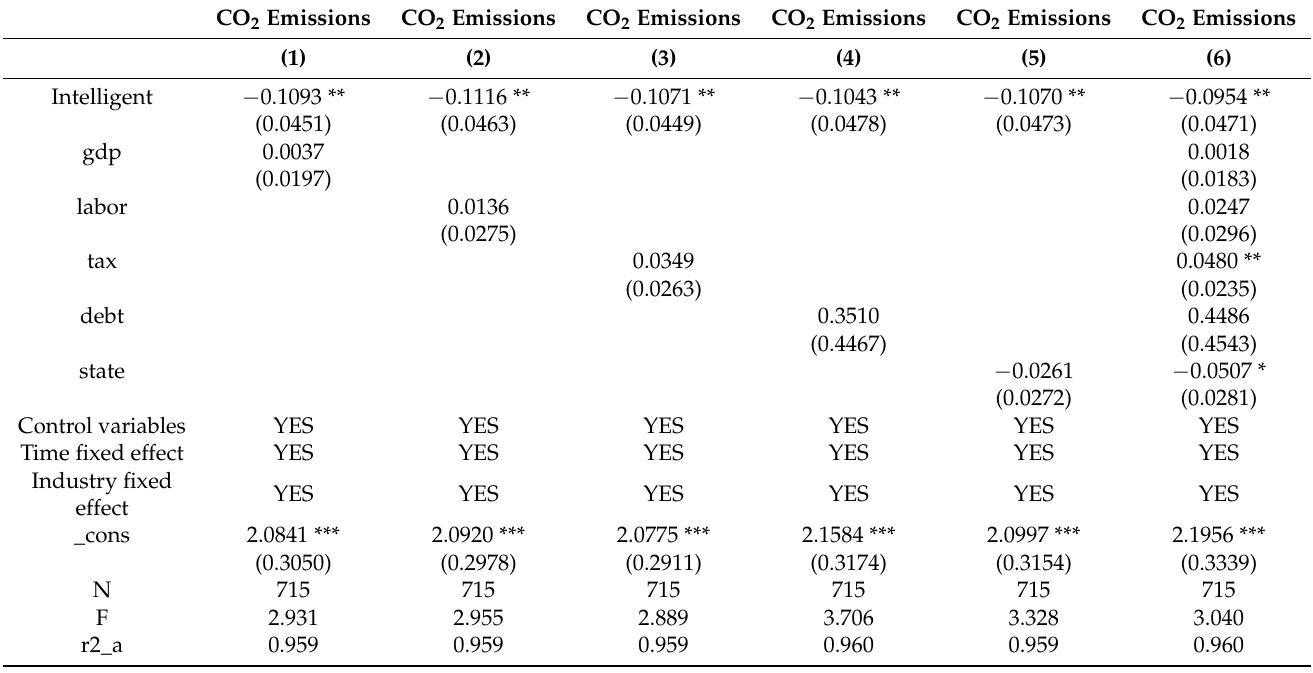
Table 10. Adding control